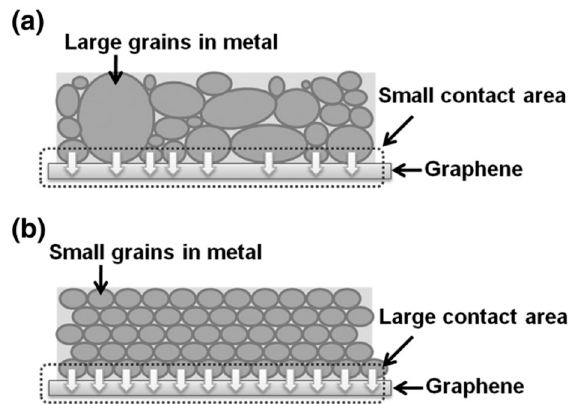
Figure 30. Schematic picture of metal contact to graphene. ( a , b ) indicate a schematic model of the metal/graphene junction for the large and small contact resistance values, respectively. The model shows that the contact resistance becomes smaller with increasing contact area between the metal grain and the graphene. Reproduced from Reference [105] with permission from Elsevier.